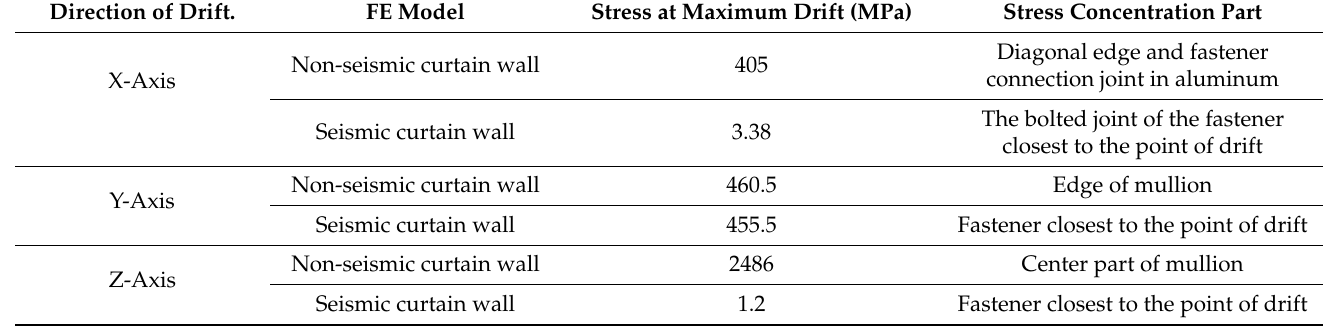
Table 9. Comparison of stress at maximum drift according to the axial direction.